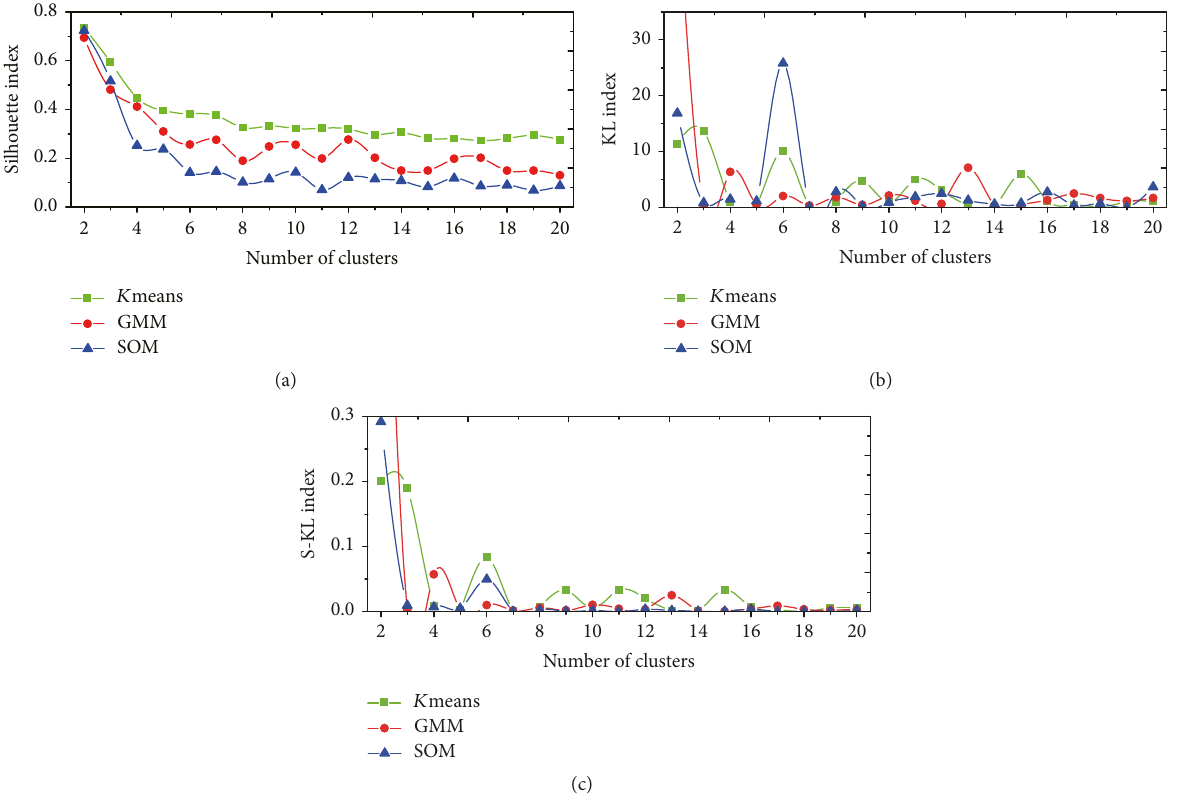
Figure 3: Cluster indexes for cluster “quality” comparison and possible cluster number selection of the 𝐾 -Means cluster, the GMM cluster, and the SOM cluster. (a) Silhouette index; (b) KL index; (c) S-KL